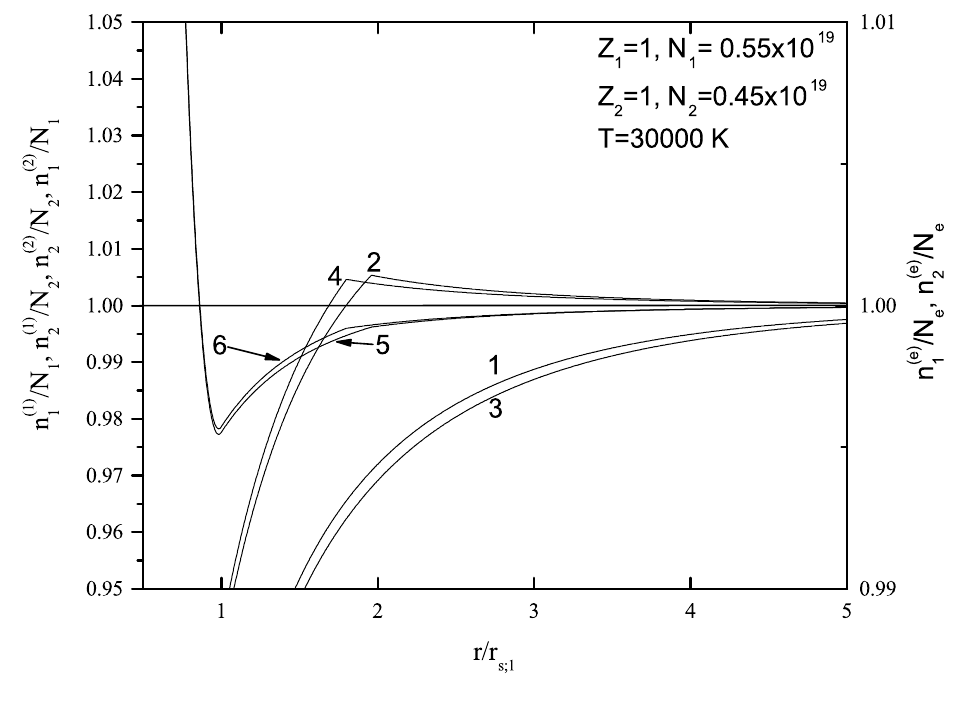
( 1 ) ( r ) / N 1 (curve marked with 1), n 1 ( 2 ) ( r ) / N 1 (curve marked with 4), and n 1